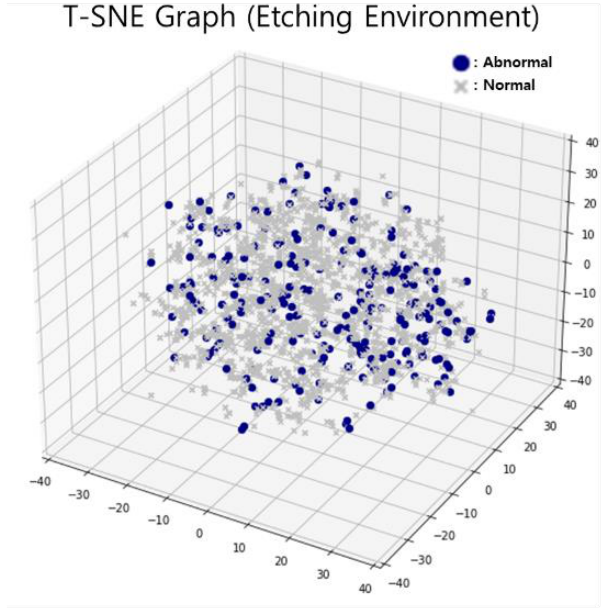
Figure 6. t -SNE graph in an etching environment.